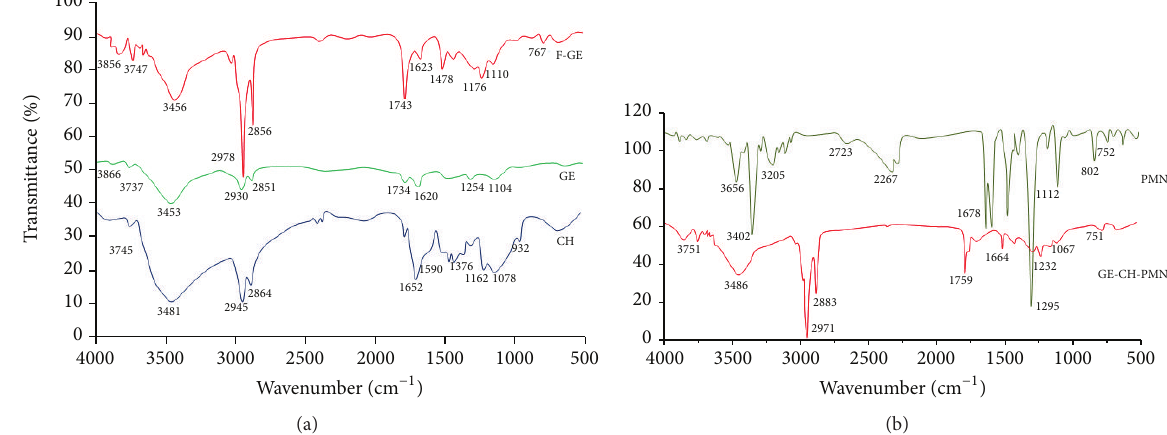
Figure 4: FTIR spectra obtained for (a) CH, GE, and functionalized GE (F-GE) and compared with those for (b) PMNA and GE-CH-PMNA composite.